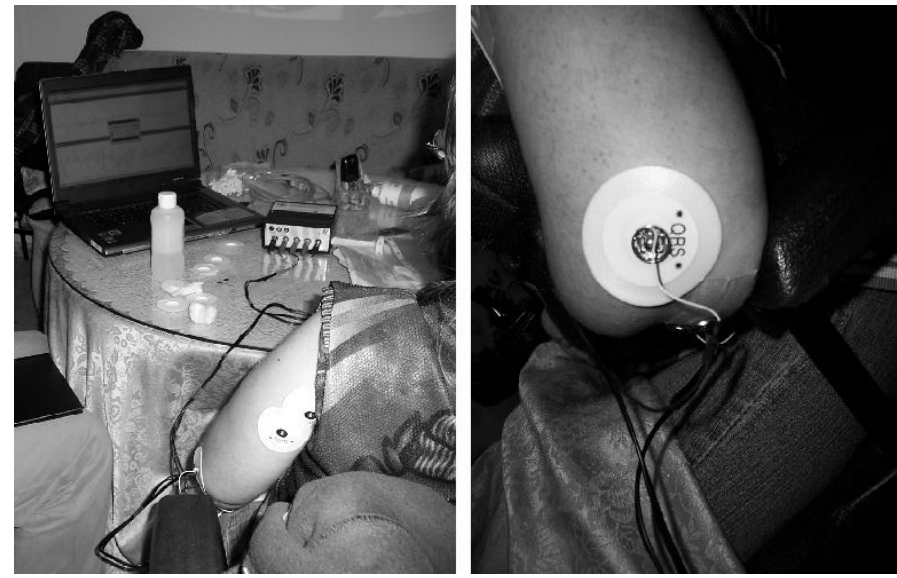
Figure 21. Tests at home with a patient with congenital muscle malformation. An ECG electrode is used as reference electrode. Smaller round Ag/AgCl electrodes (1 cm diameter) are used on the elbow as myoelectric